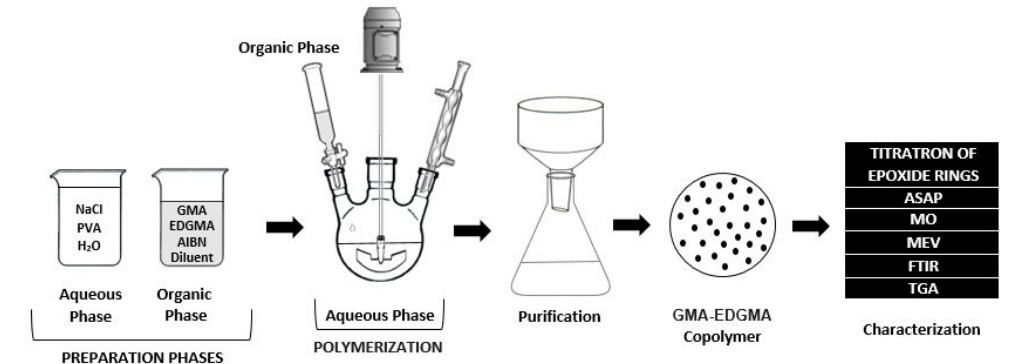
Figure 1. Schematic representation of the steps related to polymerization, purification and characterization of GMA-EDGMA copolymers.